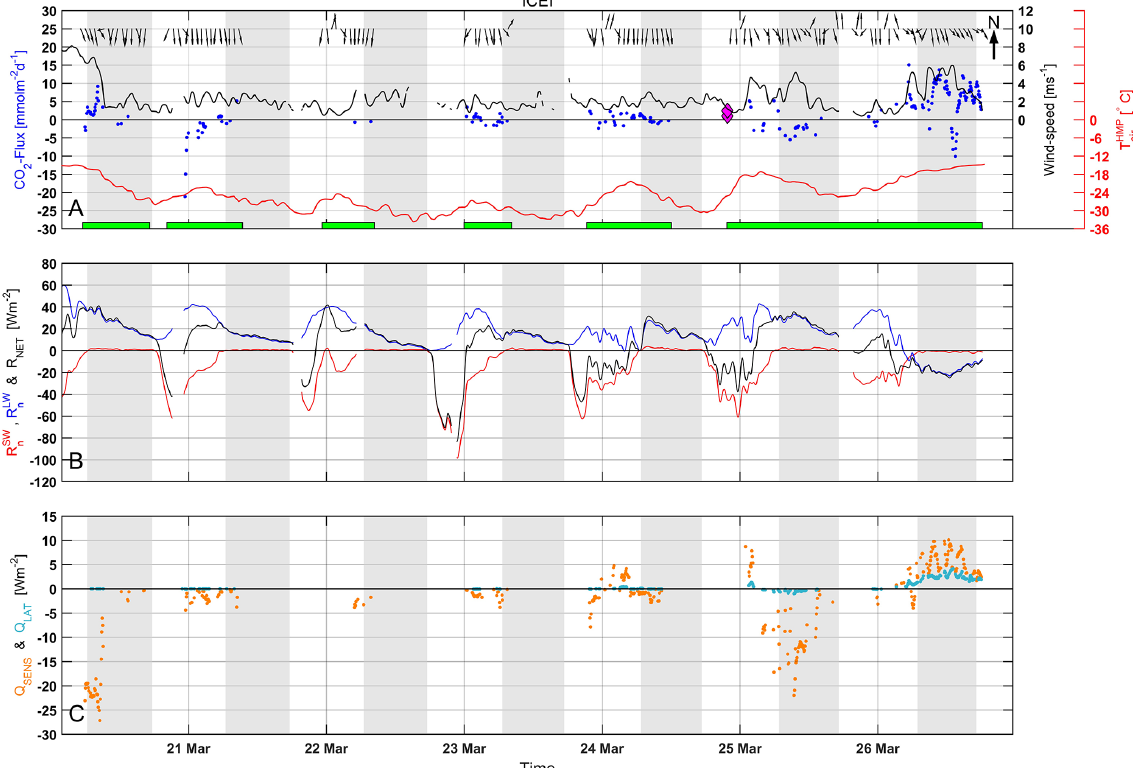
Figure 2. ICEI time series of (a) EC-derived CO 2 fluxes (blue markers), chamber observations of CO 2 flux (magenta diamonds), wind speed (black line), HMP air temperature (red line) and wind direction (black arrows). Wind direction due north is indicated in the upper right corner. Green bars indicate when the EC instruments were online; (b) net shortwave radiation (red line), net long-wave radiation (blue line) and net radiation (black line); (c) turbulent sensible heat flux (orange dots) and turbulent latent heat flux (light-blue dots). Gray shaded areas indicate